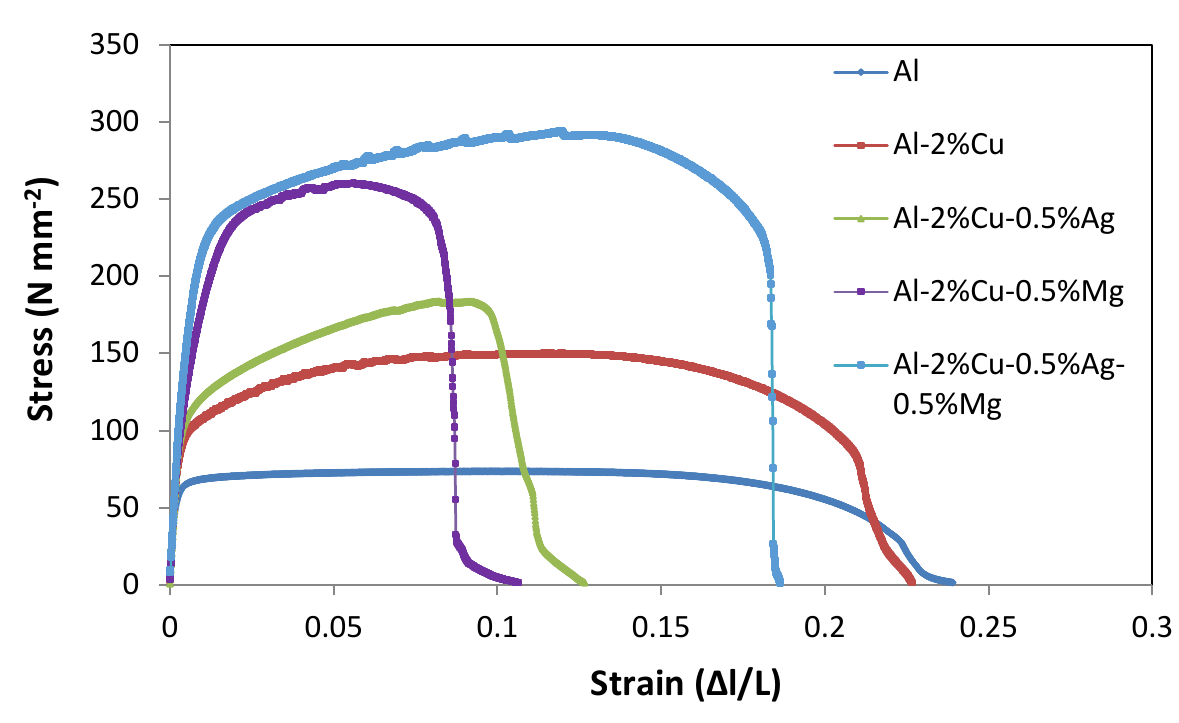
Stress – strain diagrams were plotted as shown in Figures 4 and 5 for as rolled and aging after 8 h condition and strength of the alloys were measured and presented in Table 3. The variations of strength of as rolled and different heat-treated conditions are shown in Figure 6.